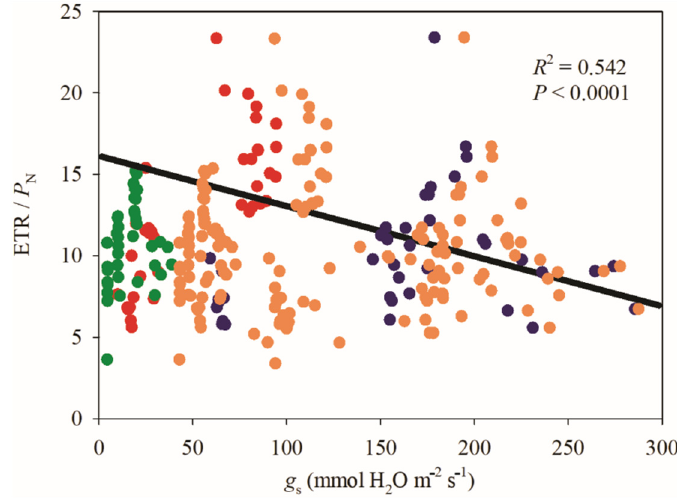
Figure 12. Relationship between the ratio of electron transport rate (ETR) and net photosynthesis ( P N ) versus stomatal conductance ( g s ) measured in four varieties (RB92579, red; RB867515, green; RB855536, blue; and RB72454, orange) of sugarcane. The evaluations were made in the dry season and rainy season with que points joined. Each point denotes one sugarcane plant. Regression coefficient ( R 2 ) and p -value are shown.